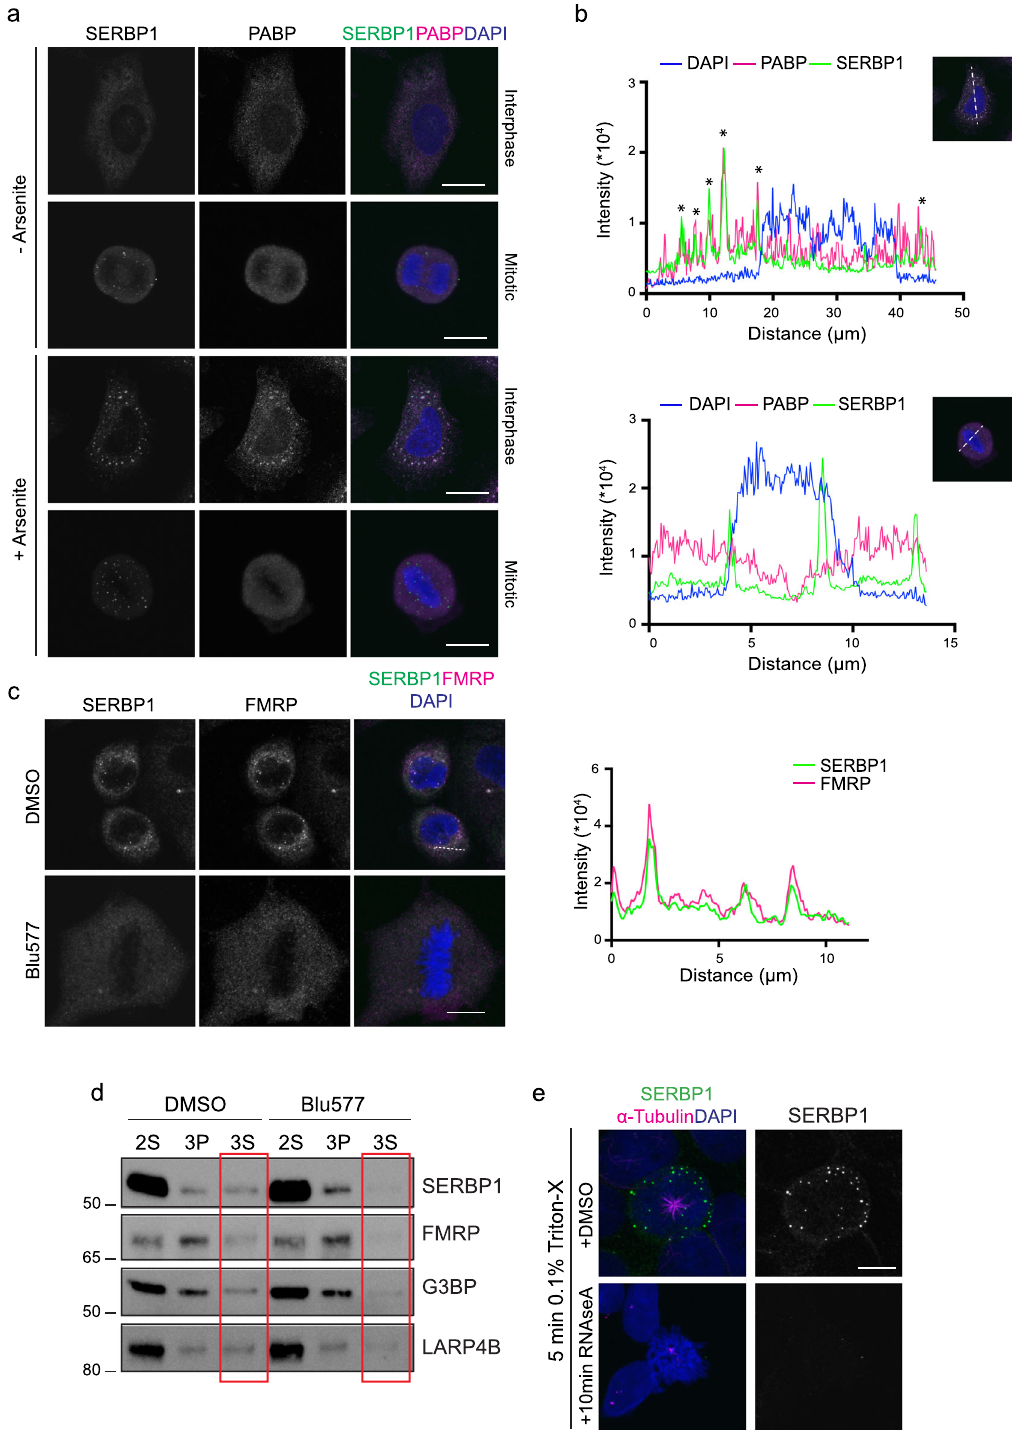
Fig. 4 SERBP1 M-bodies are distinct from the canonical stress granules. a DLD1 cells were treated with or without 0.5 mM arsenite for 30 ’ min. Cells in interphase or mitotic cells (as indicated) were stained with anti-SERBP1 (green), anti-PABP (magenta) and DAPI (blue). Scale bar, 10 μ m. b PABP (magenta) and SERBP1 (green) colocalisation pro fi le in arsenite-treated interphase cell (top) and arsenite-treated mitotic cell (bottom). DAPI pro fi le is in blue. Graphs show the fl uorescence intensity picked on the dotted white line, asterisks indicate SERBP1/PABP colocalisation. c Representative mitotic DLD1 cells treated or not with 500 nM Blu577 for 1 h. Cells were stained with SERBP1 (green), FMRP (magenta) and DAPI (blue). Scale bar, 10 μ m. On the right, the plot shows the fl uorescence pro fi le of SERBP1 (green) and FMRP (magenta) picked on the white line shown in the representative image. d Fractionation assay in mitotic enriched DLD1 cells, treated with or without 500 nM Blu577 for 1 h. The second supernatant (2 S), third pellet (3 P) and third supernatant (3 S) were immunoblotted for LARP4B, FMRP, G3BP and SERBP1, which are modulated by Blu577 in the 3 S fraction, as indicated by the red rectangles. e DLD1 cells permeabilised for 5 min with 0.1% Triton-X prior to 10 min RNaseA treatment. SERBP1 M-bodies in green, α -Tubulin in magenta and DNA in blue (DAPI). Scale bar, 10 μ m. Source data are provided as a Source Data fi